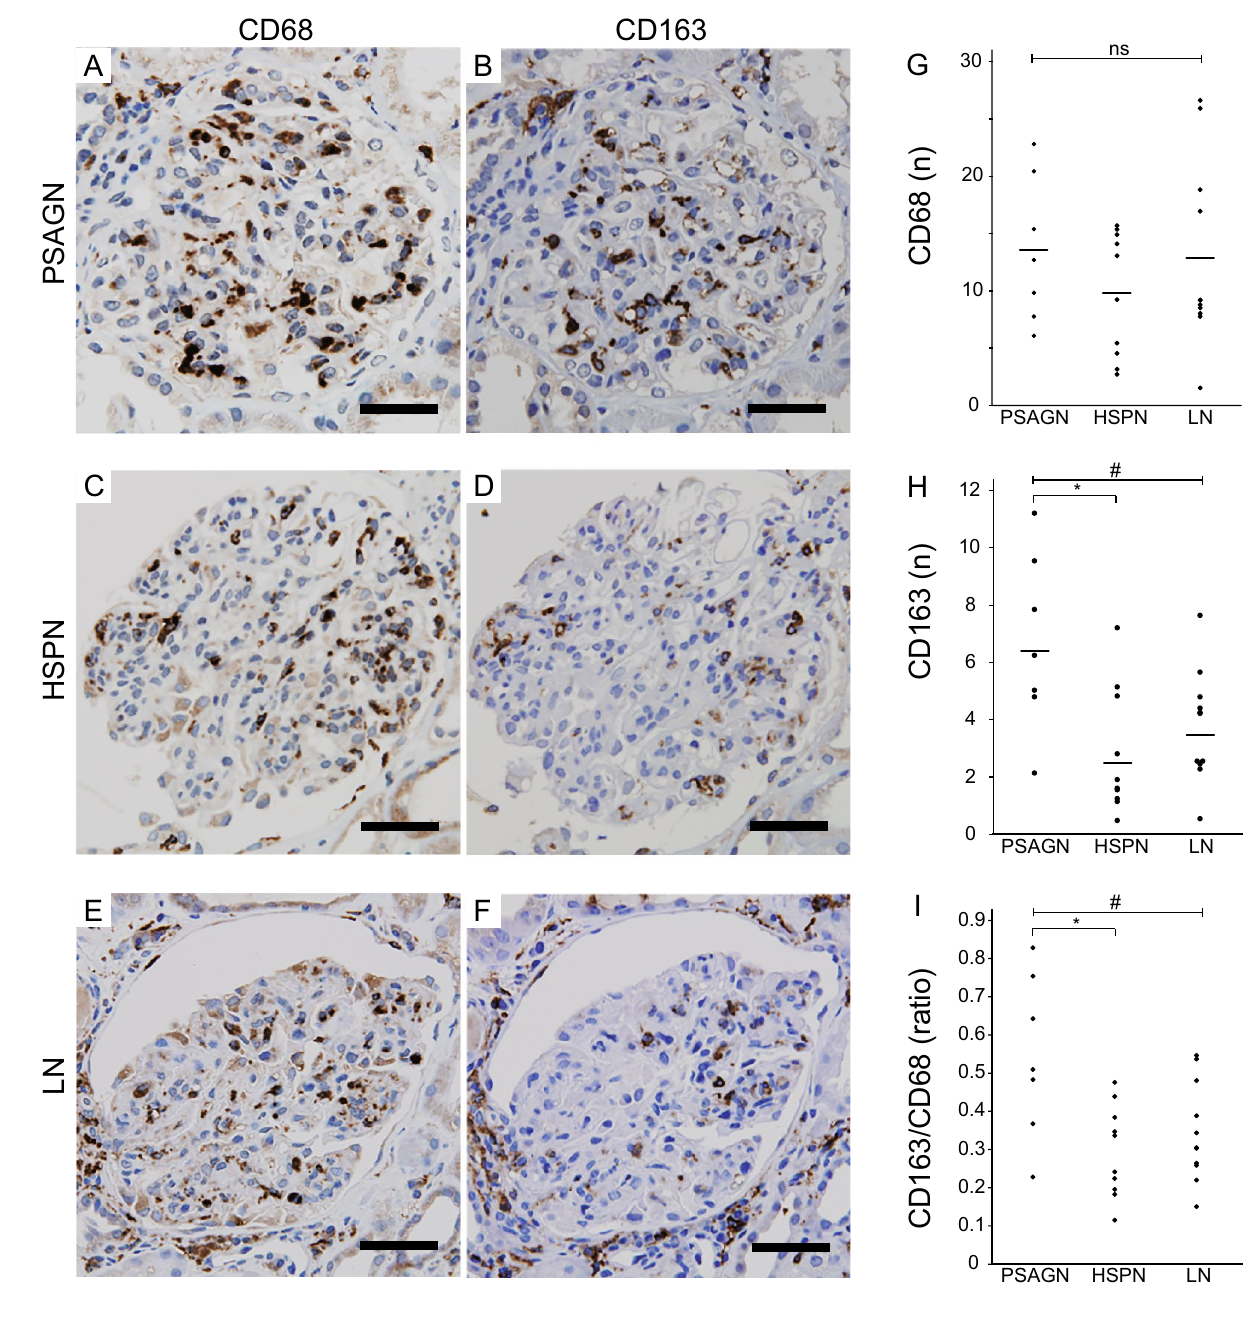
Figure 6. Heterogeneity of infiltrating macrophages in GN with EP lesions. CD68 and CD163 immunostaining of PSAGN ( A , B ), HSPN ( C , D ), and LN ( E , F ). Graphs show the number of cells positive for CD68 ( G ) and CD163 ( H ) and the frequency of CD163-positive cells per CD68-positive cell ( I ). Scale bars, 50 μm. # p < 0.05 among the three diseases by Kruskal–Wallis test, * p < 0.05 between each group by Steel–Dwass test, ns, no